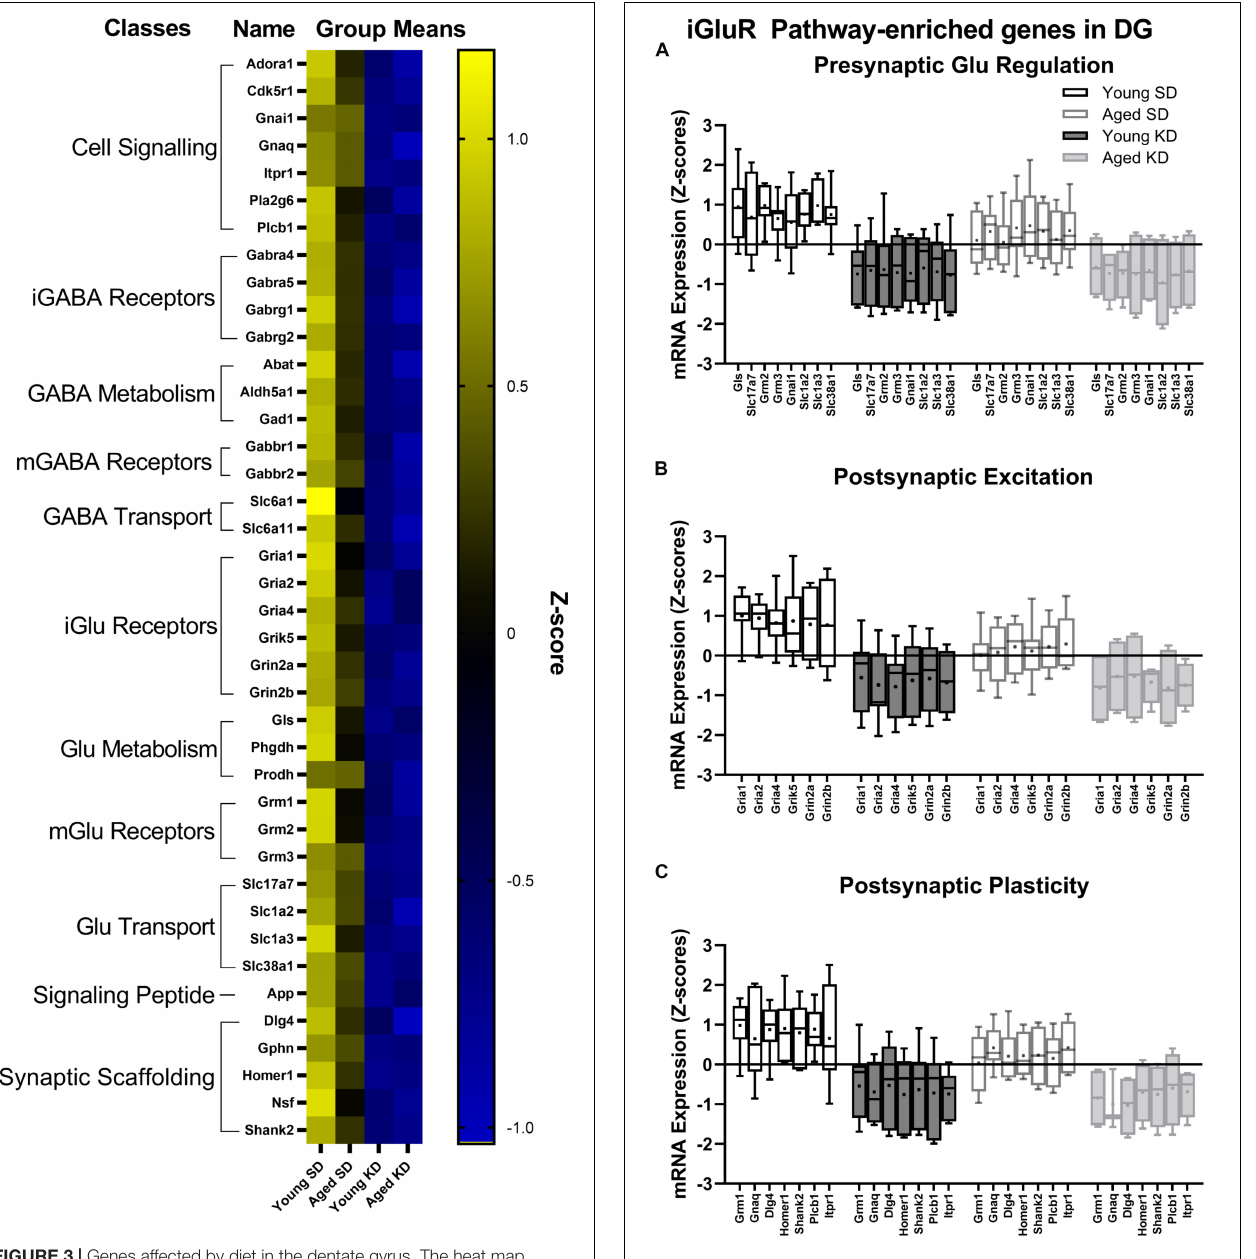
FIGURE 4 | Genes within the ionotropic glutamate receptor (iGluR) pathway in the DG reliably changed with diet. (A) 8 genes associated with presynaptic glutamate regulation were reduced as a function of diet. (B) 6 genes associated with postsynaptic excitation were reduced as a function of diet. (C) 7 genes associated with postsynaptic plasticity were reduced as a function of diet. Black bars represent young; gray bars represent aged; open bars represent standard diet; and filled bars represent ketogenic diet. Boxes represent the upper and lower quartiles around the median, the whiskers are the minimum and maximum observed values and +indicates the group